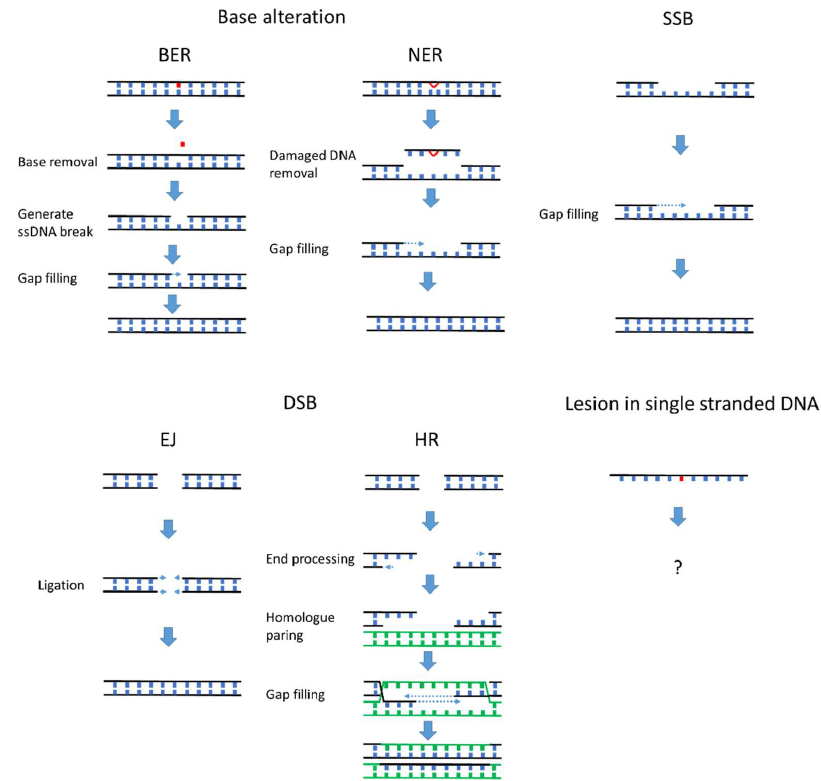
Figure 1. Many mechanisms efficiently repair DNA damage on the DNA double helix. Lesions in the double stranded DNA can be efficiently repaired by mechanisms corresponding to the specific type of DNA damage. Base-specific damage can be directly reversed by particular enzymes such as photolyases and O6-methylguanine DNA methyltransferase (MGMT) (reviewed in [4]). The majority of base-specific damage is repaired by base excision repair (BER) and nucleotide excision repair (NER). In BER and NER, the damaged base or surrounding DNA is excised from the double stranded DNA. The gap left behind is then filled by a DNA polymerase. Single stranded breaks (SSBs) are recognized by poly(ADP-ribose) polymerase 1 (PARP1), which activates downstream signaling that leads to gap-filling by DNA polymerases. Double stranded breaks (DSBs) are repaired by end joining (EJ) or by homologous recombination (HR). EJ directly ligates the exposed DSB with DNA ligase, while, during HR, break sites are replicated using undamaged homologous sequences of sister chromatid templates. In contrast, DNA lesions in single stranded DNA (ssDNA) cannot be repaired by BER, NER, HR, or EJ and must be remediated using alternative mechanisms (as suggested by the question mark in the figure). Post replication repair is a mechanism specialized in tolerating lesions in single stranded